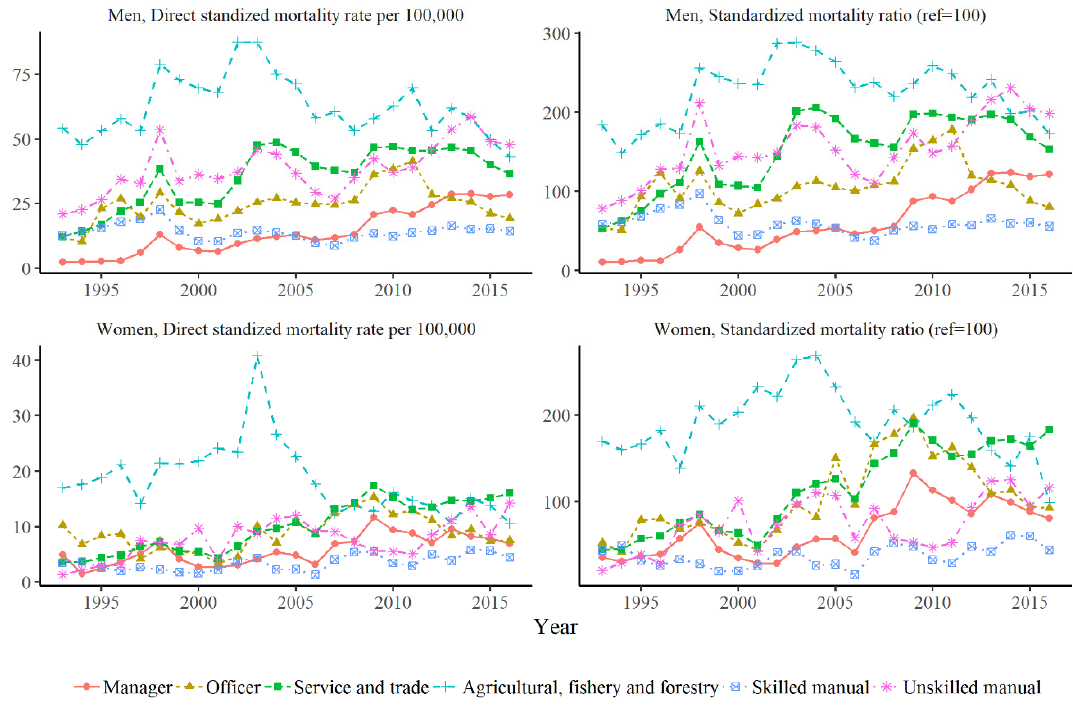
Figure 1. Direct standardized mortality rate per 100,000 and standardized mortality ratio (ref = 100) from 1993 to 2016. Reference population was total working population during 1993–2016.